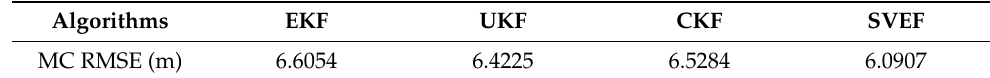
Table 3. MC RMSE for different algorithms.